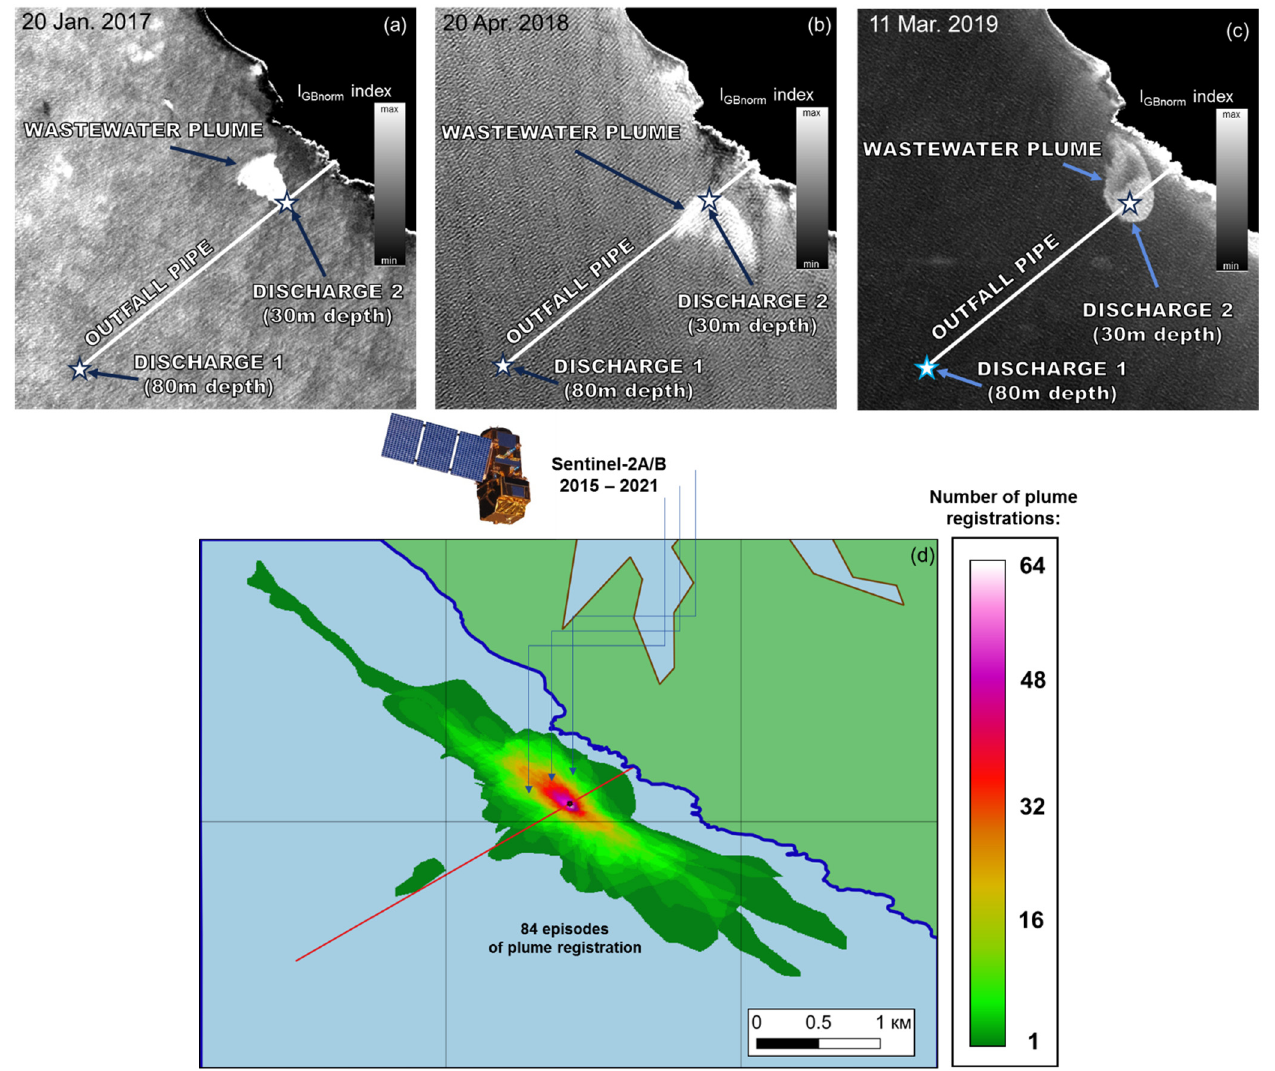
Figure 7. Example spatial distributions of normalized color index, I Gbnorm (SENTINEL-2A/B): ( a ) January 20, 2017; ( b ) April 20, 2018 г .; ( c ) March 11, 2019 г .; ( d ) generalized map of plume registrations near Sevastopol, presented as a color-coded spatial distribution of a number of plume detection events.